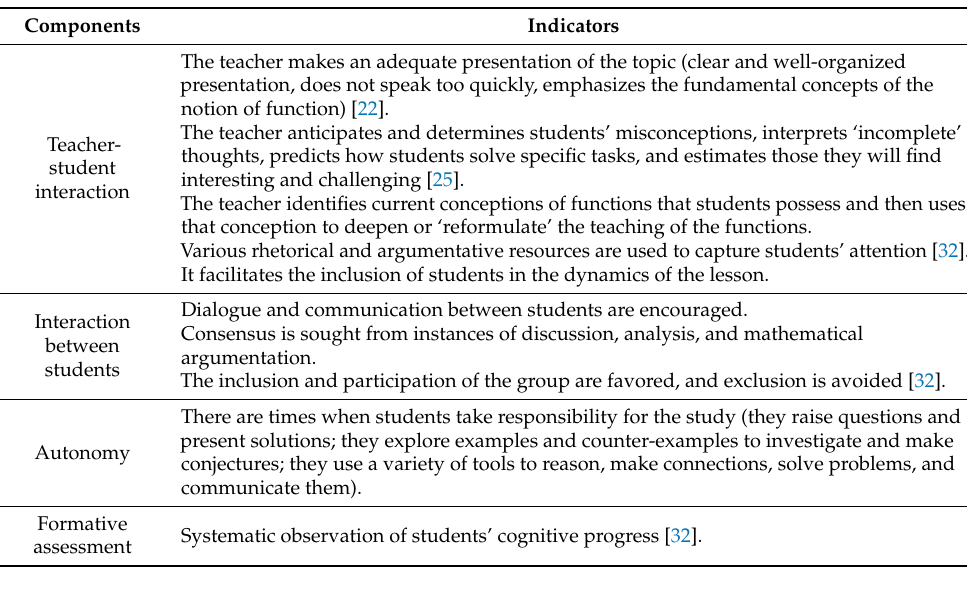
Table 4. Interactional suitability for teaching functions.